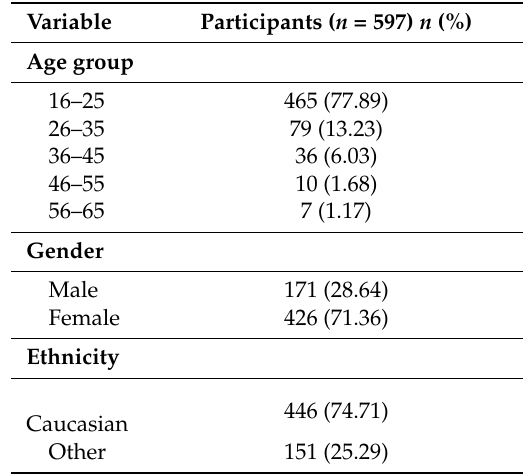
Table 1. Demographics of the memory